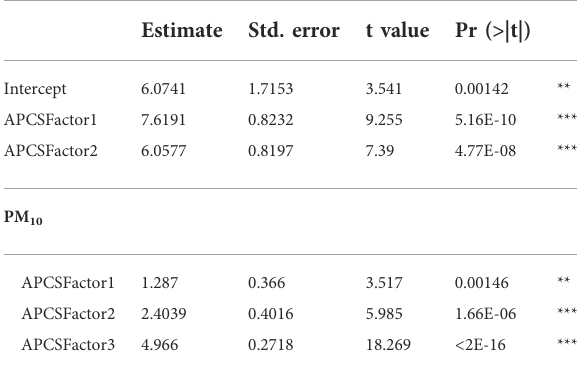
TABLE 3 Results of the MRA model for evaluating the source contribution. PM 10 Estimate Std.